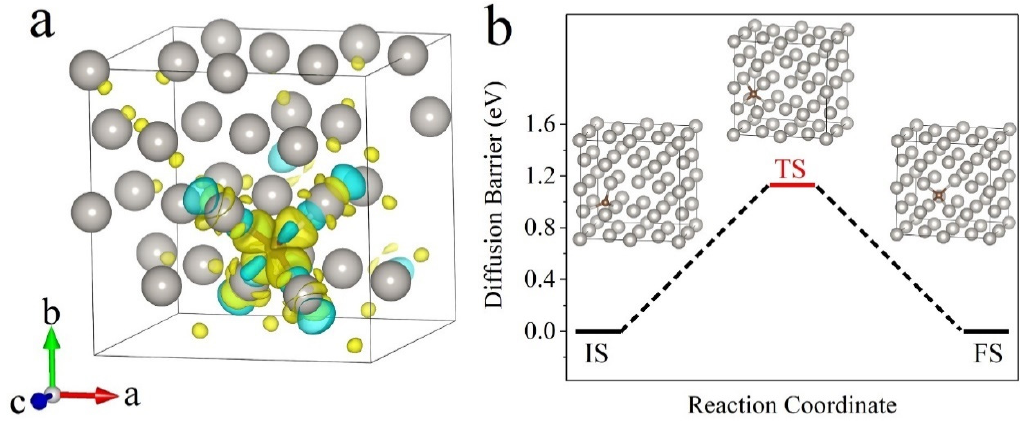
Figure 7. Calculation of the possibility of C atom doping into Pt lattice. ( a ) Charge density di ff erence contours are plotted, in which, the yellow and cyan isosurfaces represent positive and negative charge density, respectively. ( b ) Calculated potential energy profiles between initial state (IS), transition state (TS), and final state (FS) when moving a tetrahedral C atom to another equilibrium tetrahedral position.